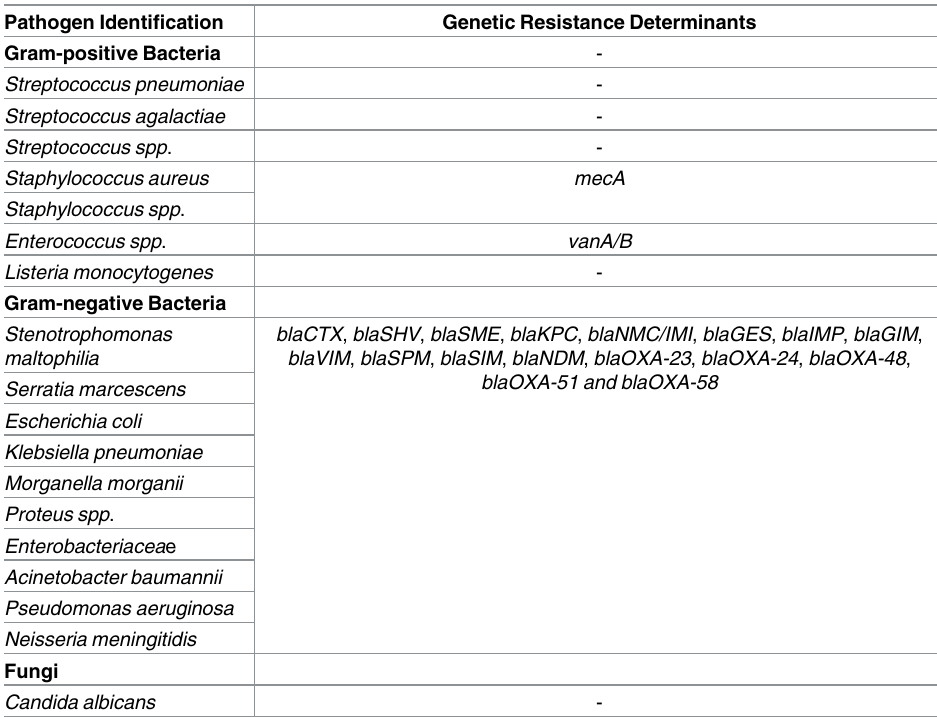
Table 1. Clinical pathogens and genetic resistant determinants detected by Sepsis Flow Chip